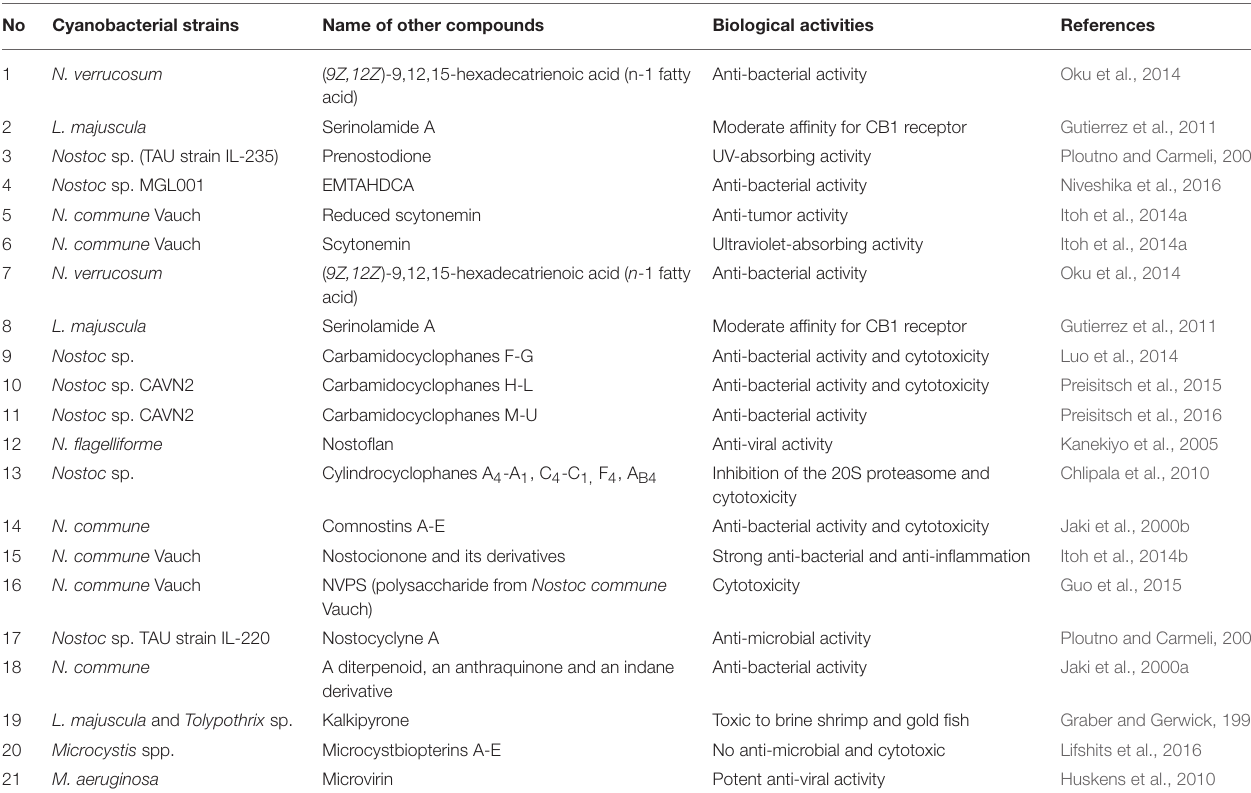
TABLE 5 | List of other class